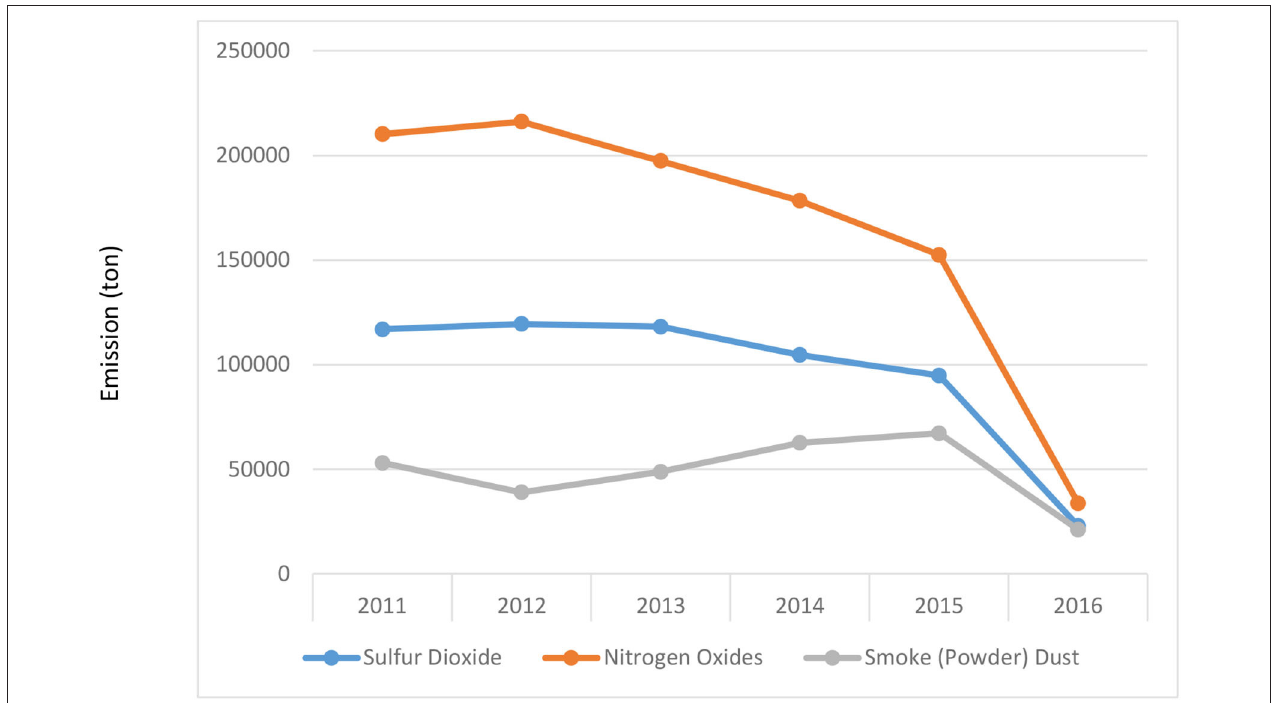
FIGURE 2 | Interannual variations of major pollutant emissions in Z City from 2011 to 2016.